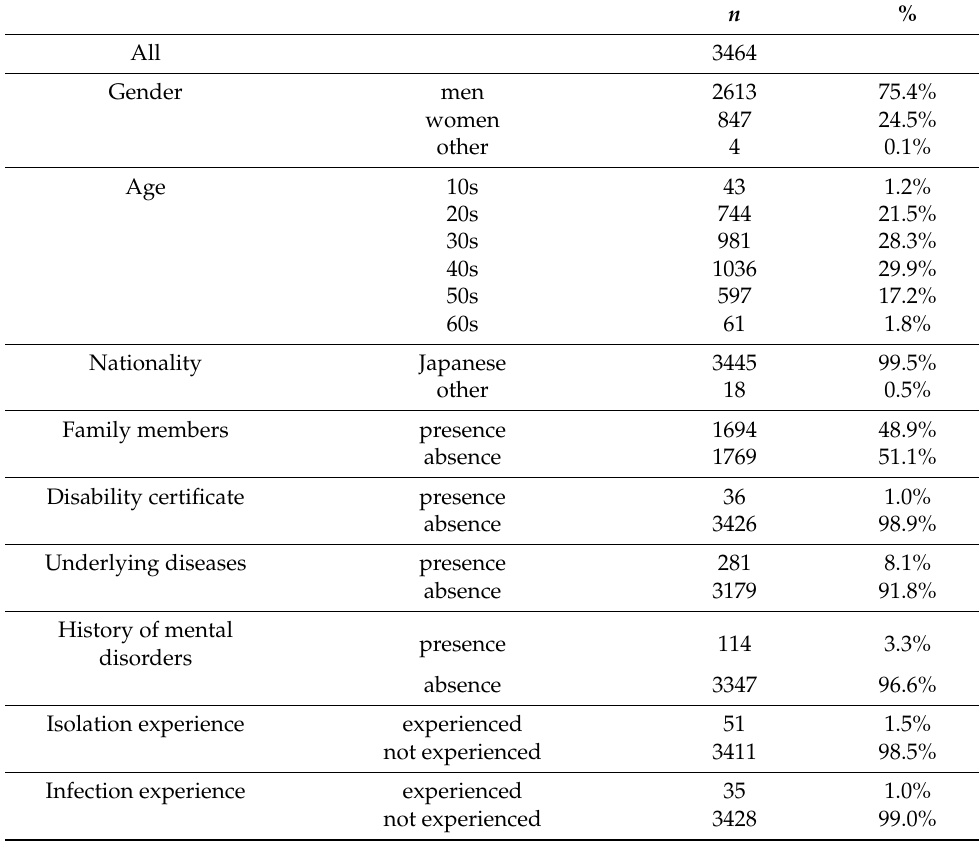
Table 1. Demographic